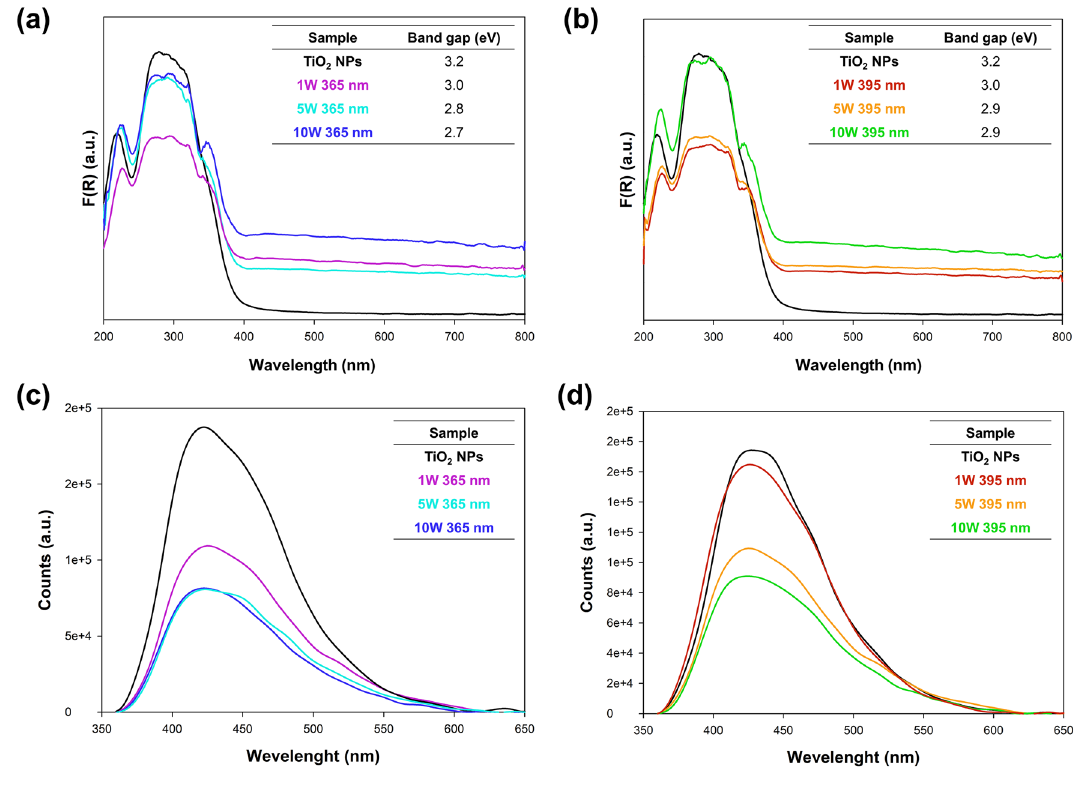
Figure 6. The ( a , b ) DRS and ( c , d ) fluorescence spectra for sample from ( a , c ) 365 nm and ( b , d ) 395 nm series.